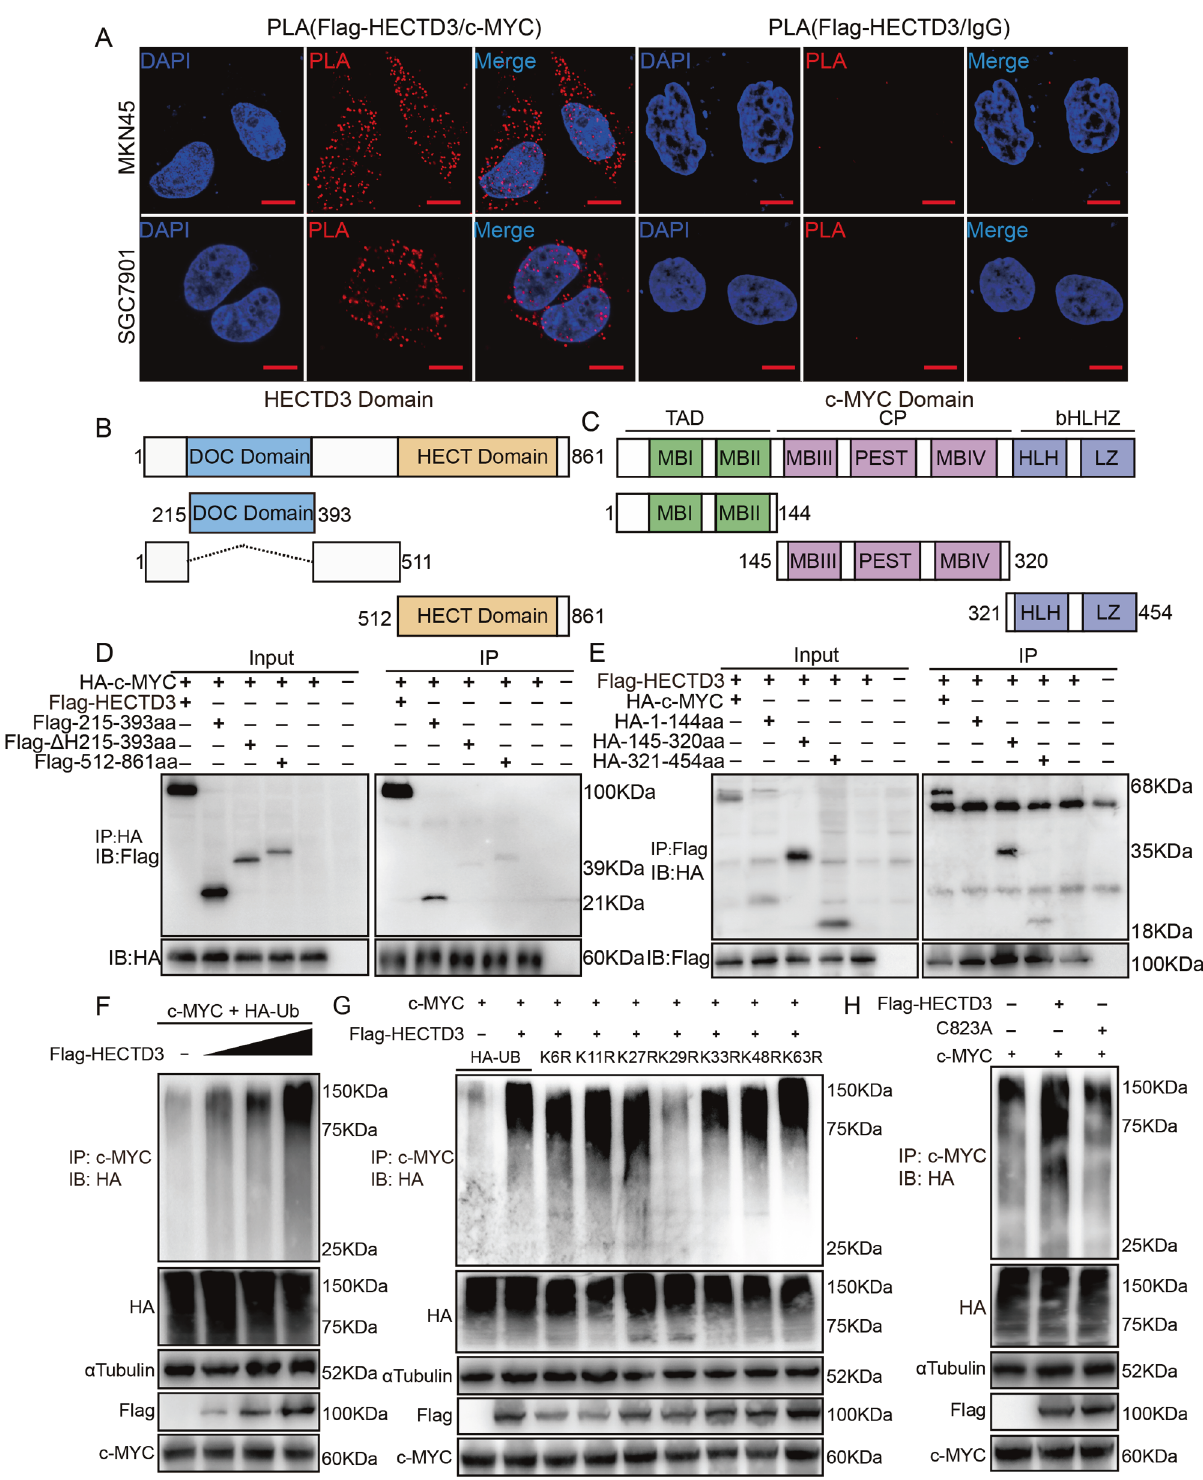
Fig. 5 HECTD3 interacts with c-MYC and mediates K29 site-linked polyubiquitination of c-MYC. A The proximity ligation (PLA) experiments were applied to assess the interaction of HECTD3 and c-MYC. B DOC and HECT domains diagram of HECTD3. C TAD, CP, and bHLHZ domains diagram of c-MYC. D , E Interaction between c-MYC and HECTD3 truncated domains in 293FT cells. F 293FT cells were cotransfected with c- MYC, HA-Ub, and increasing amounts of HECTD3 plasmids and treated with MG132 were immunoprecipitated using PARP1 beads and immunoblotted using an anti-HA antibody. G The Flag-HECTD3, c-MYC, HA-Ub, and ubiquitin mutant plasmid were cotransfected and treated with MG132 for ubiquitination assays in 293FT cells. H The Flag-HECTD3, c-MYC, HA-Ub, and C823A were cotransferred and treated with MG132 for ubiquitination assay in 293FT cells.